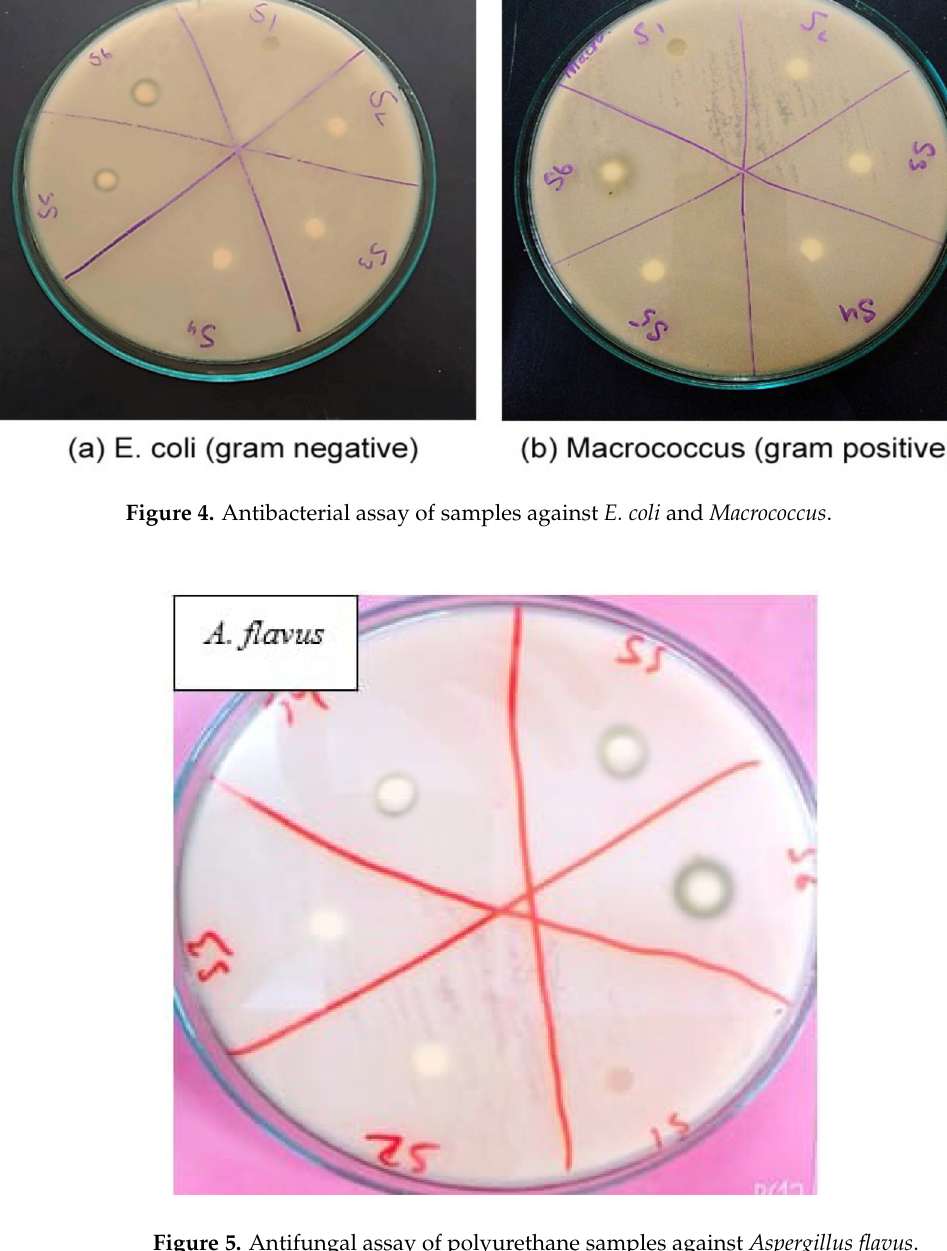
Figure 5. Antifungal assay of polyurethane samples against Aspergillus flavus